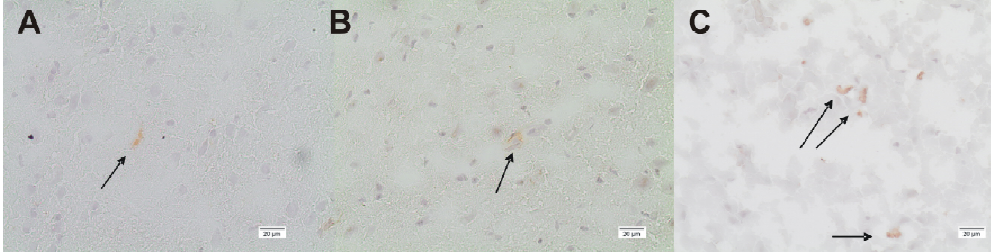
Figure 8. Immunohistological staining of DDAH2 ( A – C ). ( A ) DDAH2 expression in control rat brain sections is rare. In this FOV only one positively stained cell can be observed; ( B ) perilesional DDAH2 24 h after TBI and ( C ) lesional DDAH2 24 h after TBI ( A – C : magnification 200×) ( → : examples for positively stained cells).